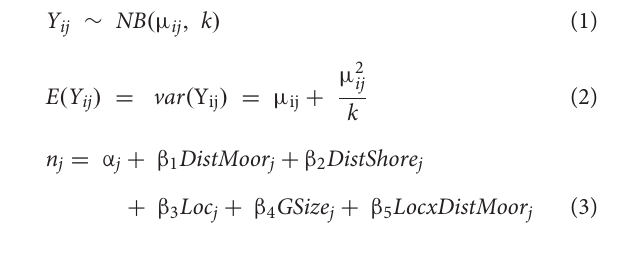
locations. All sampling was subtidal at between 3 and 8 m below MLWS. Samples were collected during February and March